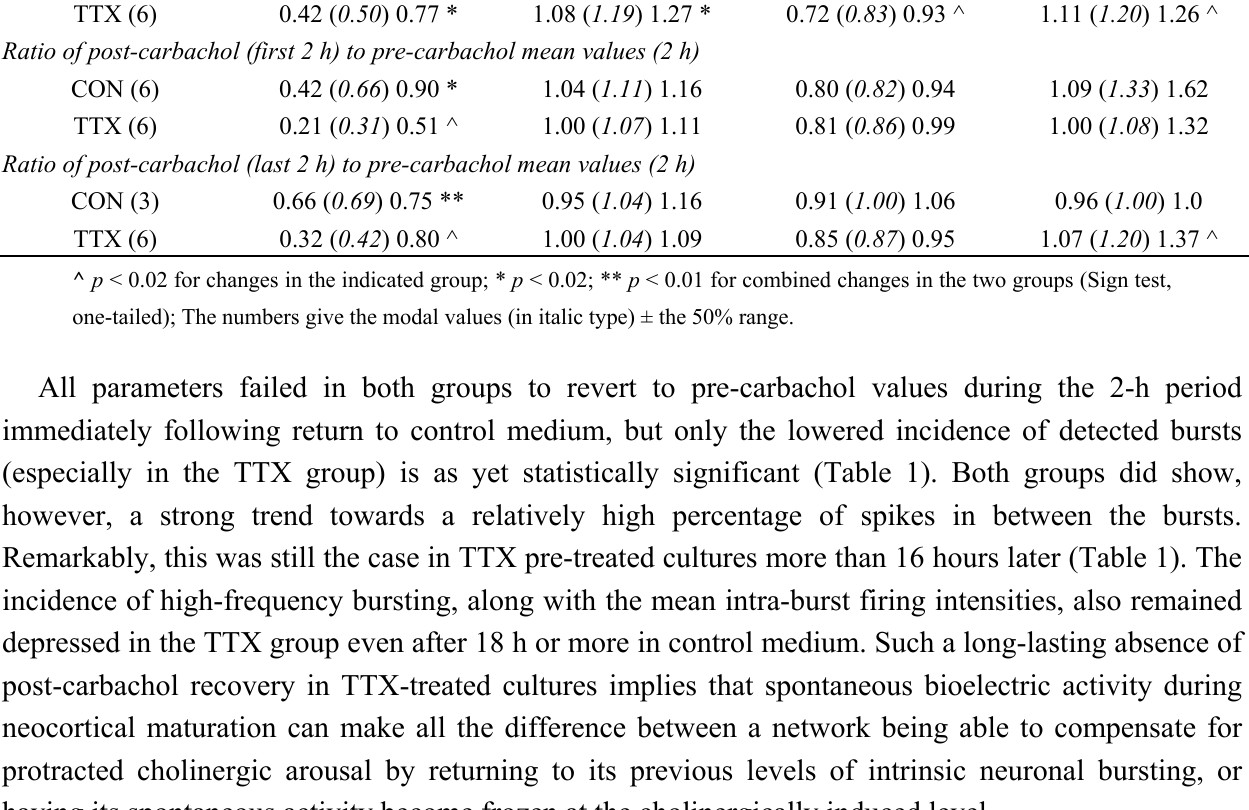
Table 1. Acute and lasting effects of cholinomimetic activation in developing rat neocortex cultures. Bursts Rate/min Duration (ms) Intensity (sp/s) Spikes-inter (%) Ratio of in-carbachol (first 2 h) to pre-carbachol mean values (2